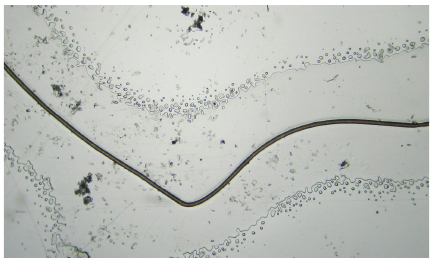
Figure 5: Hair shaft of the child showing